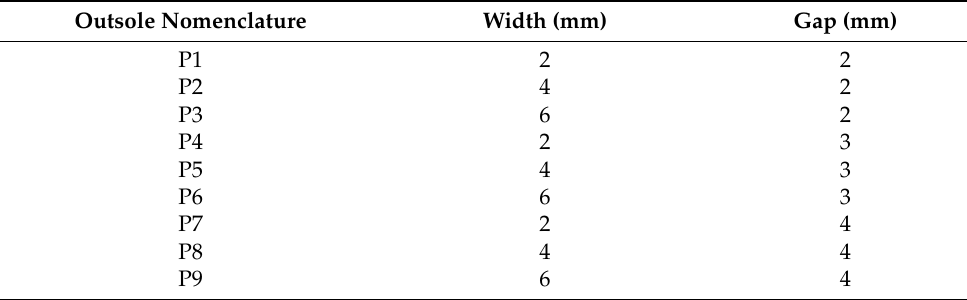
Figure 1. Dimensions of the original footwear tread design. Table 1. Parametrical modifications in the outsole’s design.